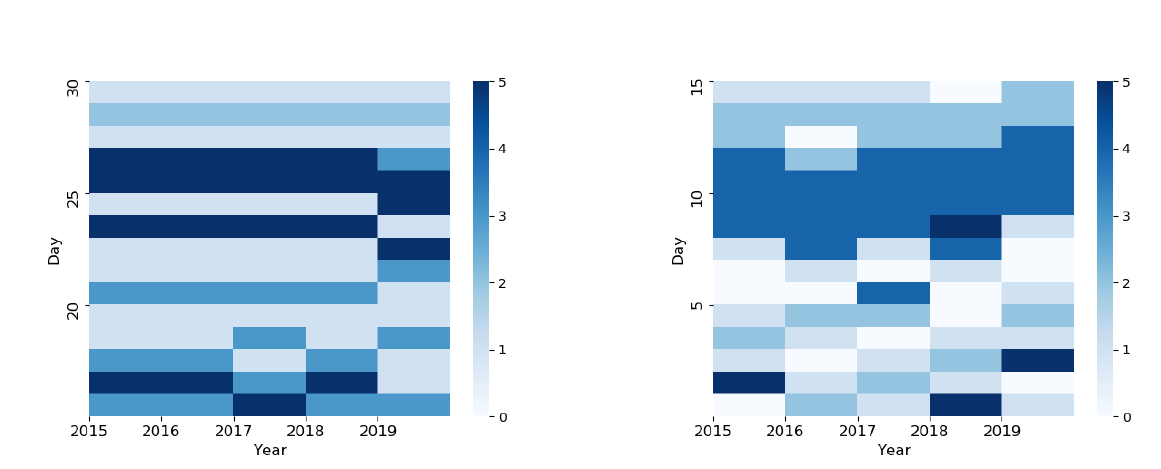
Figure 17: Clustering output for O 3 for last 15 days in Q 2 over 2015 to 2019.